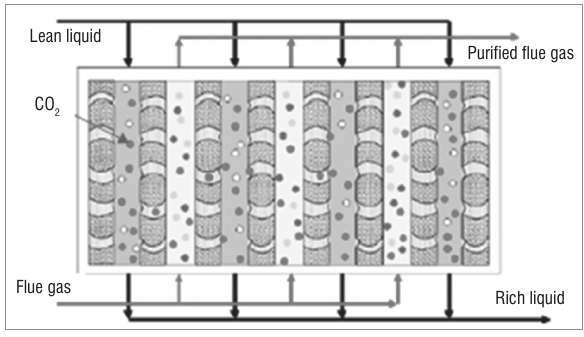
Membrane separation